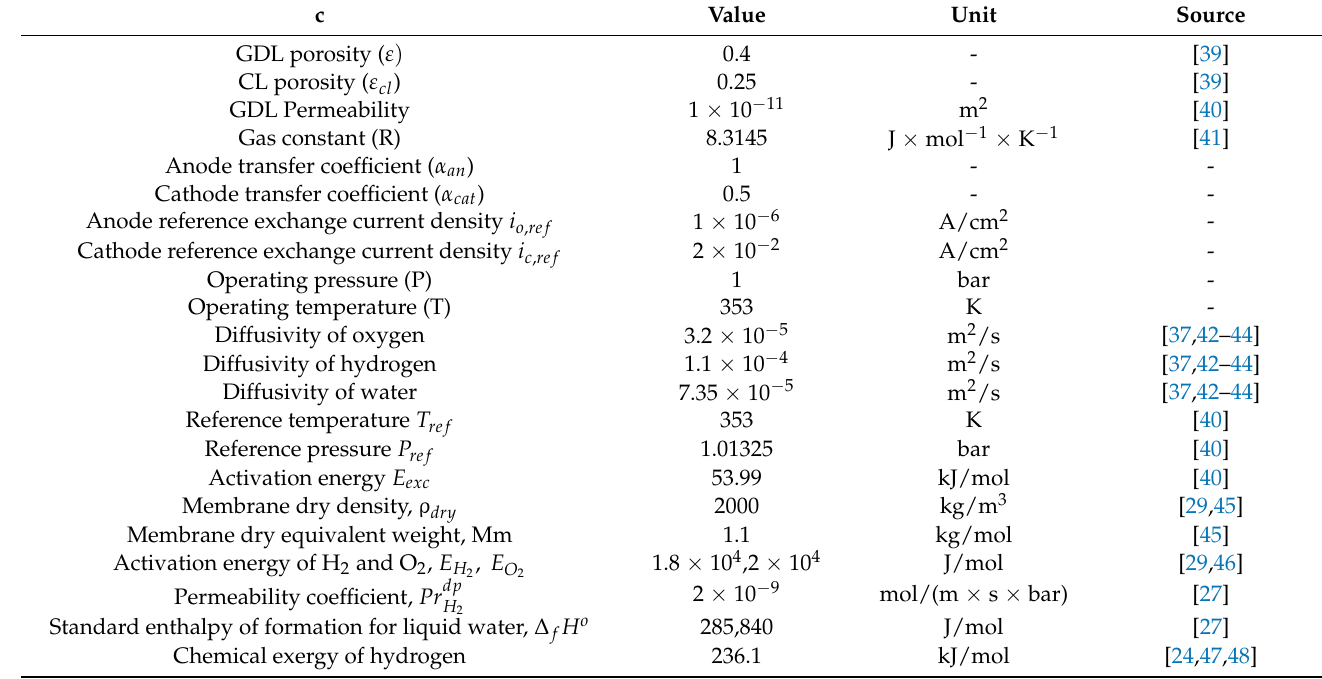
Table 2. Physical properties and operating conditions for the